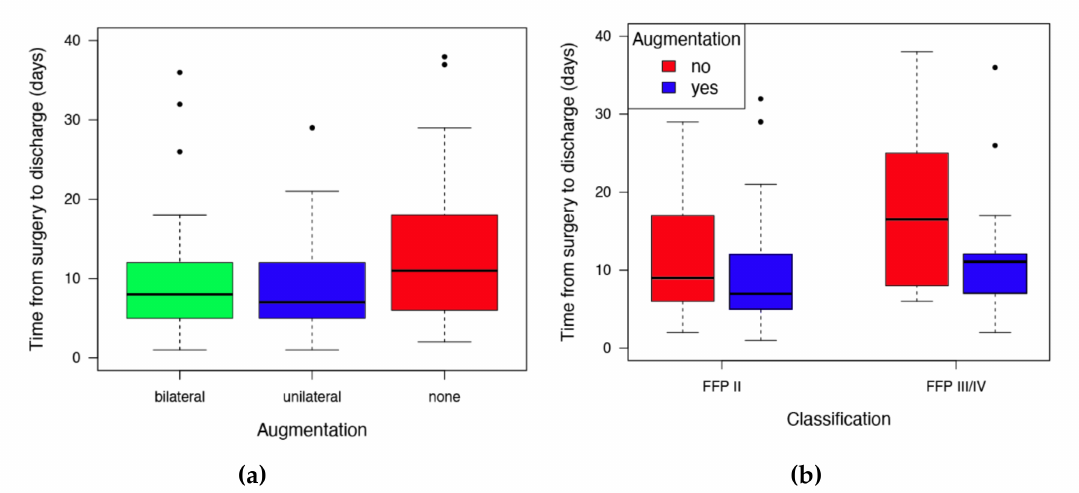
Figure 5. Postoperative duration of stay in the FFP cases: ( a ) bi-lateral and unilateral showing about a 25% shorter stay in hospital compared to the non-augmented group; ( b ) di ff erentiation between the FFP II and FFP III / IV also shows the e ff ect of augmentation with earlier discharge after augmentation. Dots indicating outliers.